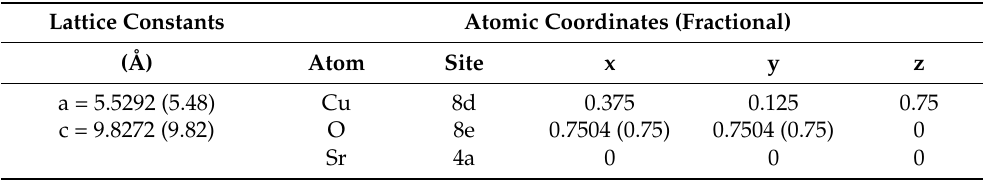
Figure 1. Crystal structure of SrCu 2 O 2 with the space group I41/amd. Table 1. Optimized structural parameters of SrCu 2 O 2 . The corresponding experimental values [39] are given in the following parentheses for comparison.